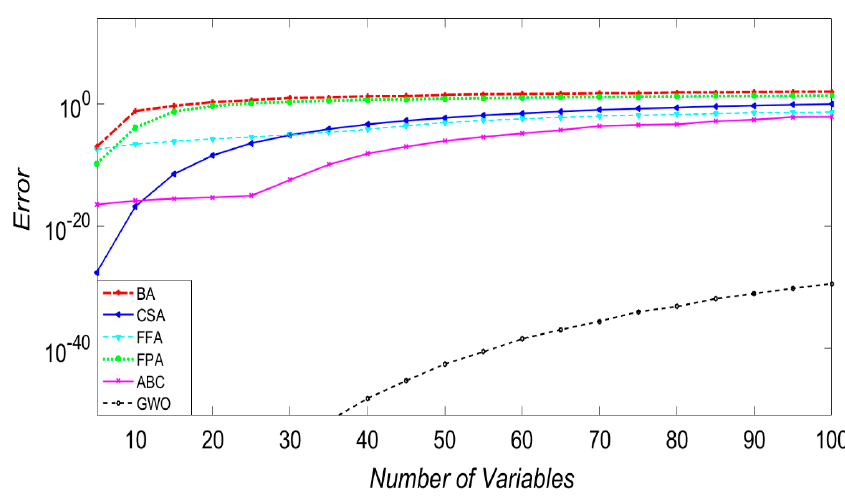
Figure 8. Error vs. variable number for Sphere function.